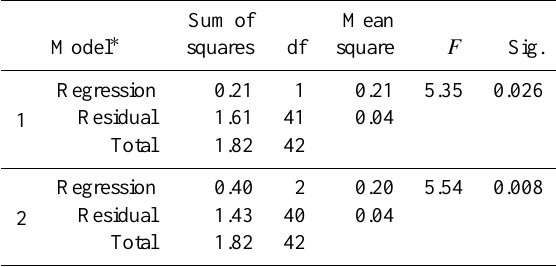
Table 5. ANOVAs for the regressions of precipitation in January.